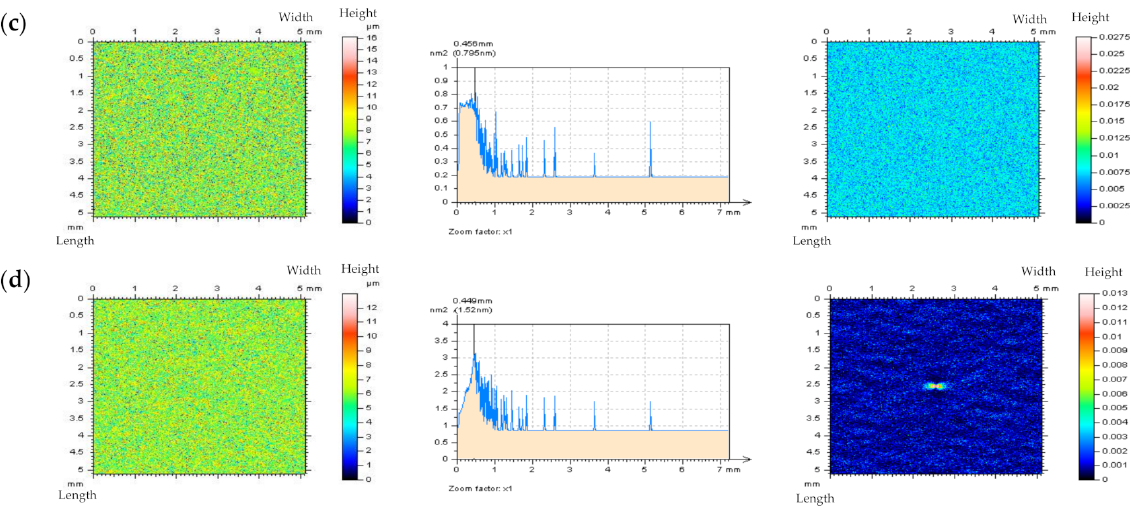
Figure 15. NSs, their PSDs, and threshold ACFs, respectively, identified for the composite surface topography measured with an optical technique, filtered by: ( a ) CSSF, ( b ) OPGF, ( c ) OPSF, and ( d ) CSOF procedure; cut–off = 0.025 mm.